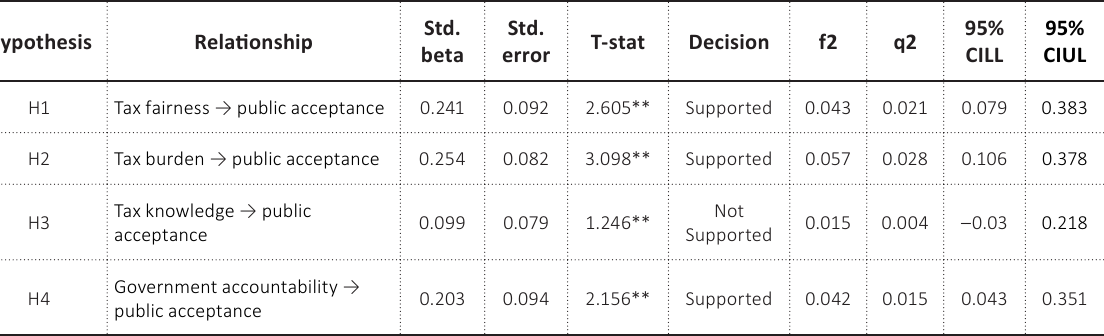
Table 9. Direct relationship hypotheses testing